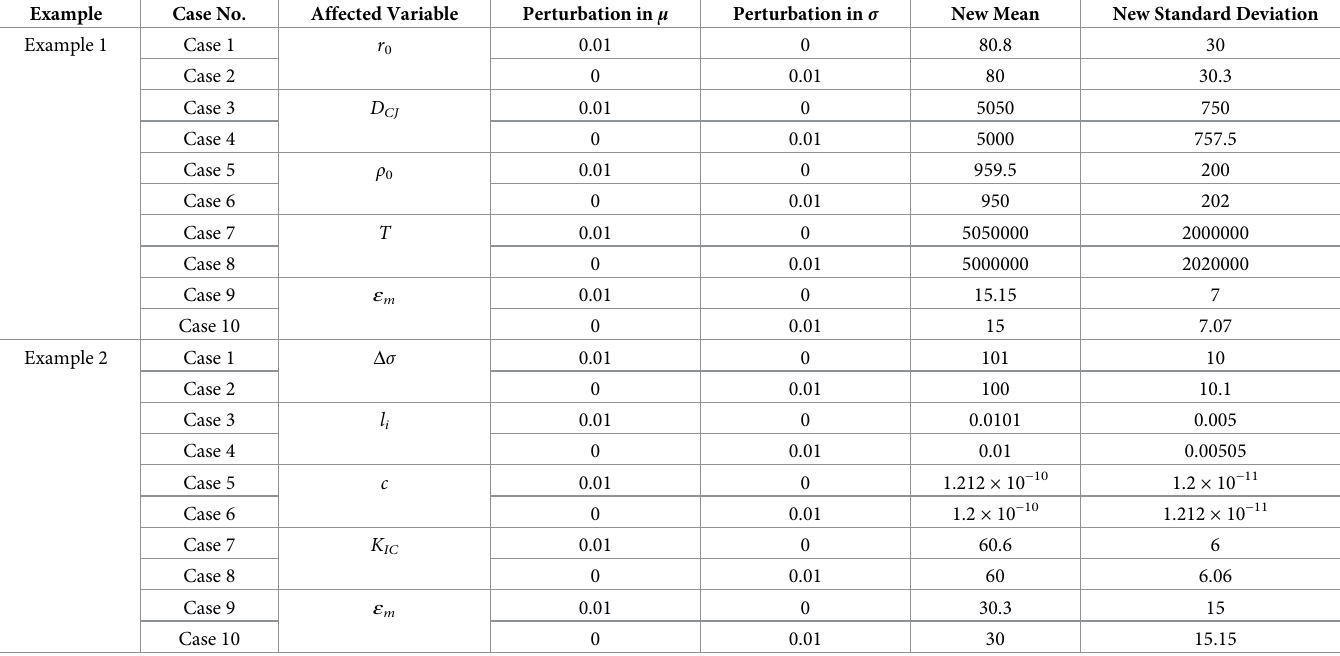
Table 3. New means and standard deviations of random variables after applying perturbations.